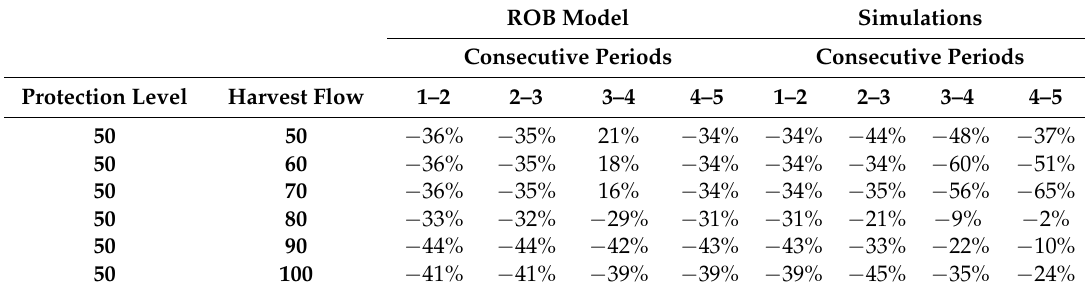
Table 4. The real (achieved) harvest flow percentages for ROB models and simulations for 50% protection level in the first PP.